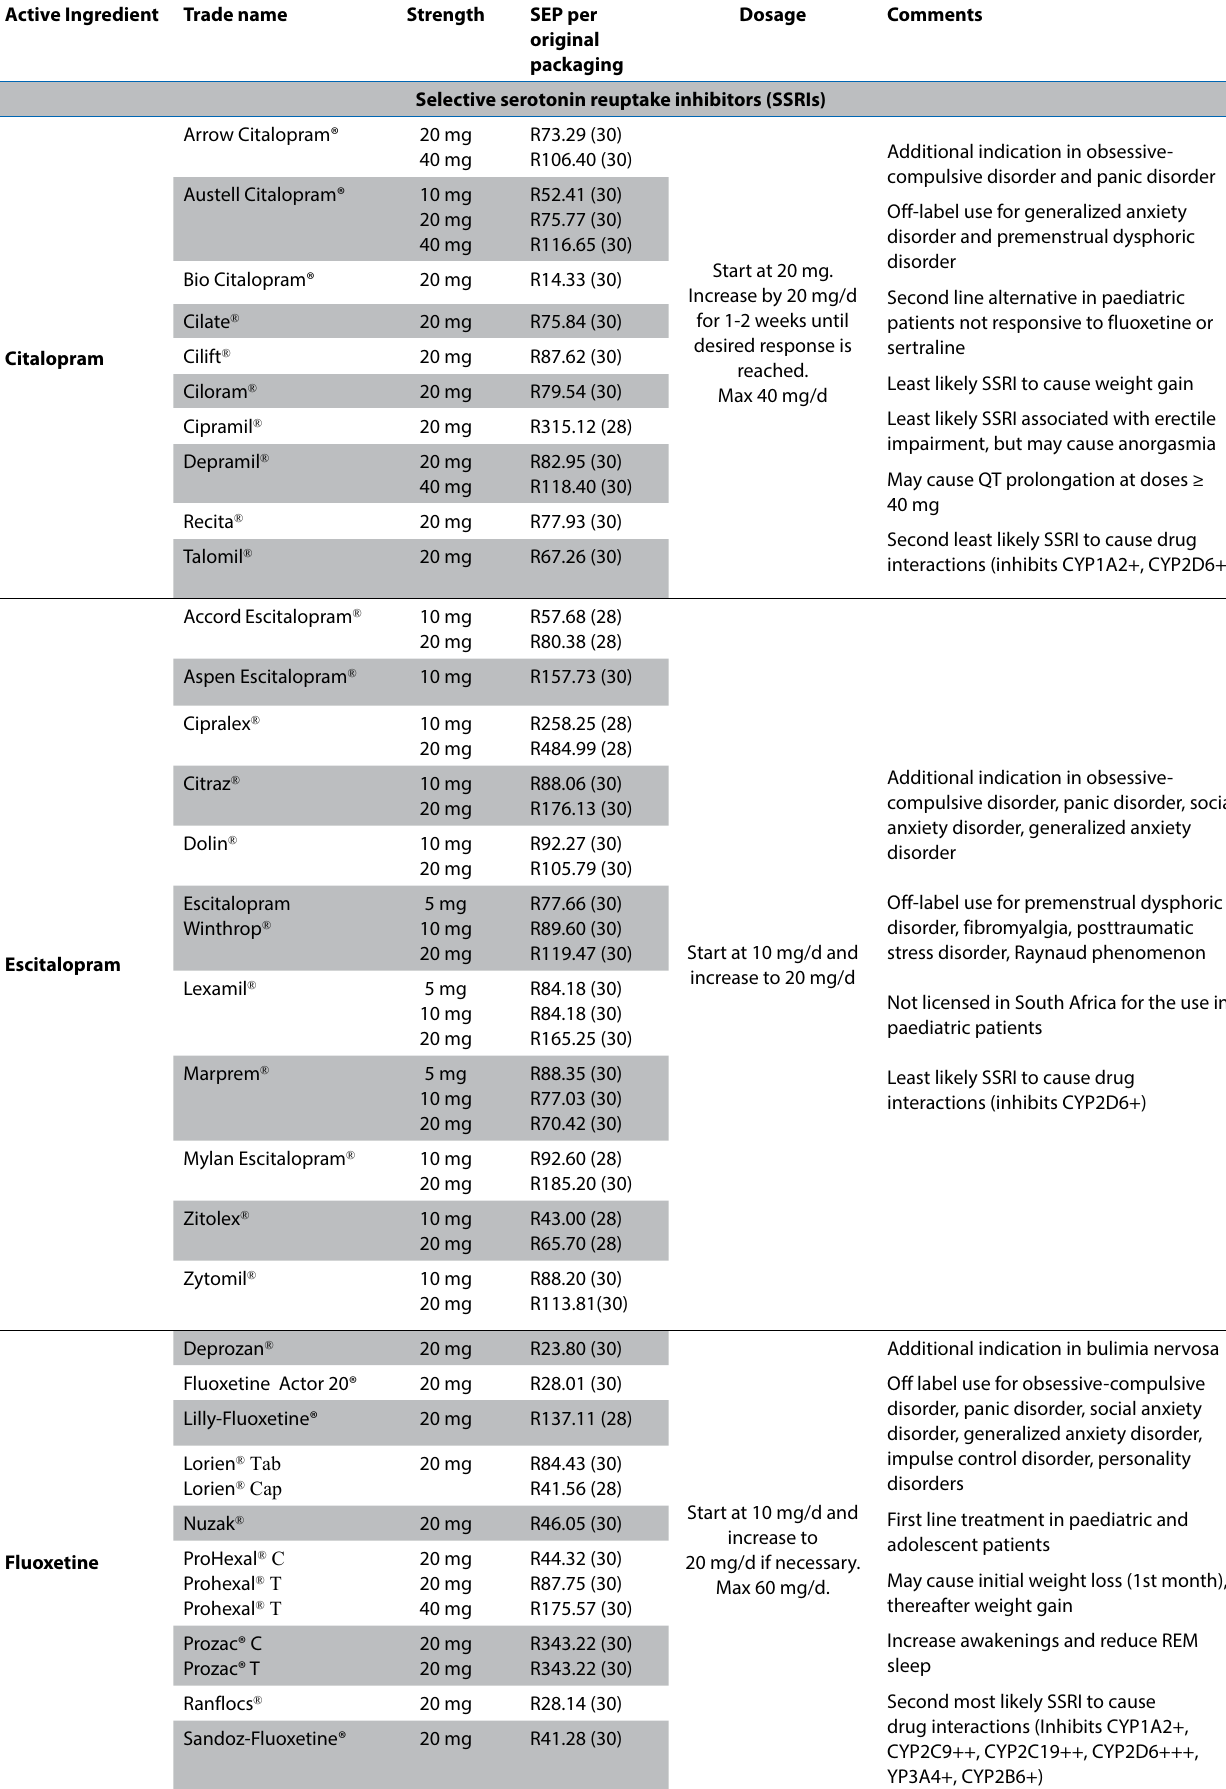
Table I. Available agents in the management of depression in South Africa Active Ingredient Trade